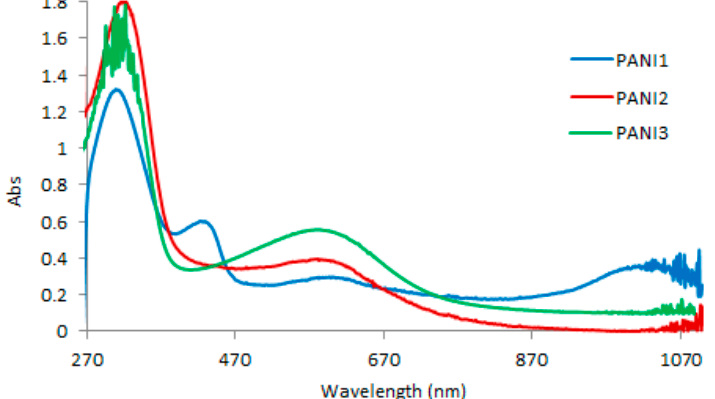
Figure 3. UV-vis spectra of PANI1, PANI2 and PANI3 in dimethylformamide (DMF) solution.